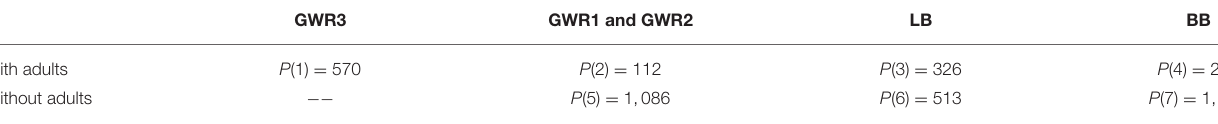
TABLE 3 | P -values at different sites ( number · m − 2 · y − 1 ).